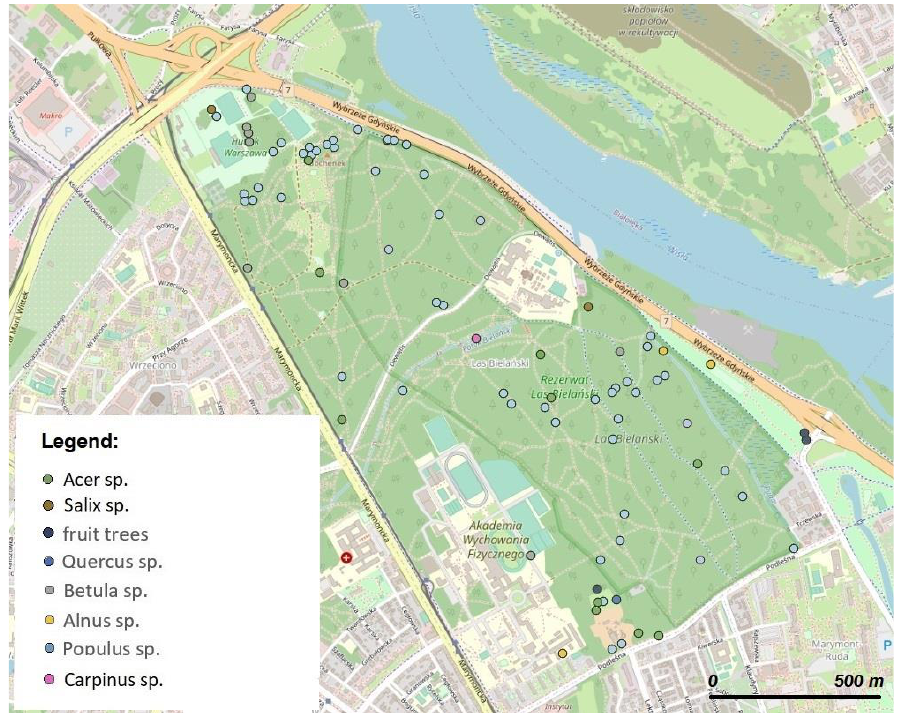
Figure 6. Location and species differentiation of defoliated trees in the Bielański Forest in Warsaw (Poland) (author’s elaboration based on the High Structural Diversity Tree Crown Map database [77]).